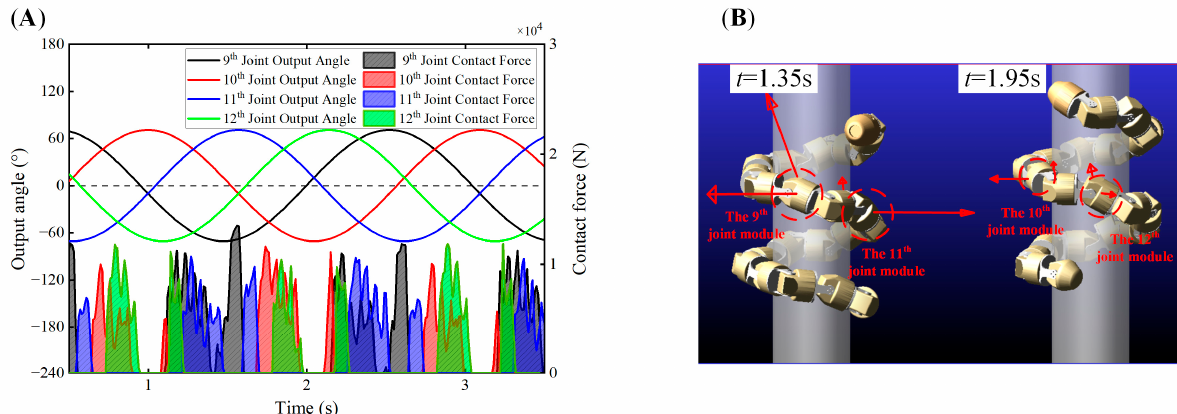
Figure 17. The output angle and contact force of four adjacent joints: ( A ) the output angle and contact force of joint modules; and ( B ) the contact force is applied to modules at different time points.